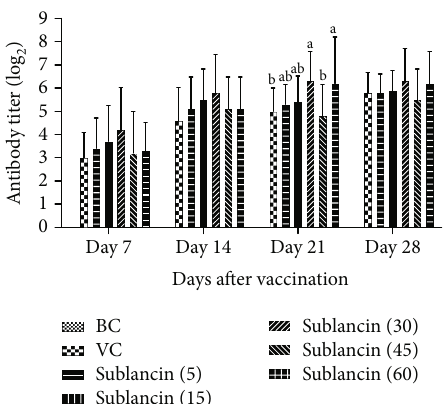
Figure 1: The dynamic variation of HI antibody titer in each group ) in Exp. 1. a,b Bars in the same day without the same (log 2 superscripts di ff er signi fi cantly ( P < 0 : 05 ).